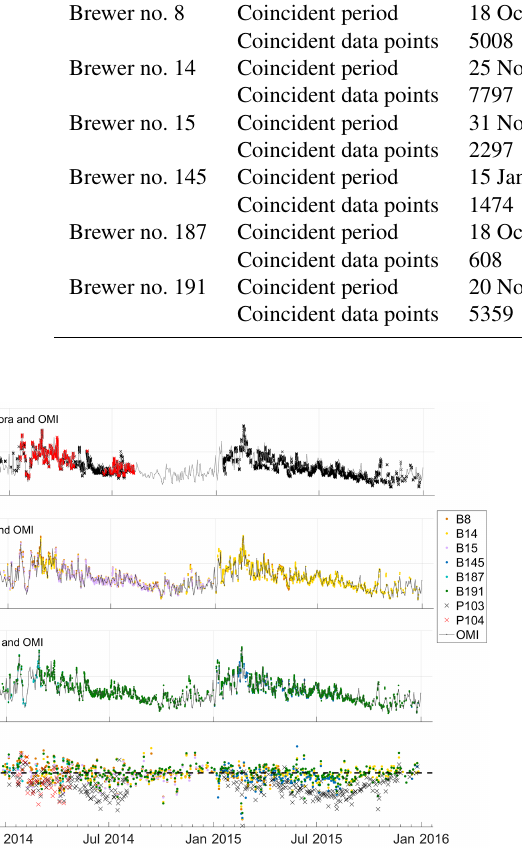
Figure 1. Ozone total column data from Pandoras, Brewers, and OMI: (a) Pandora nos. 103 and 104 compared with OMI–TOMS; (b) Brewer triad (Brewer nos. 8, 14, and 15) compared with OMI– TOMS; (c) Brewer triad double (Brewer nos. 145, 187, and 191) compared with OMI–TOMS; (d) the daily mean difference, Brewer (or